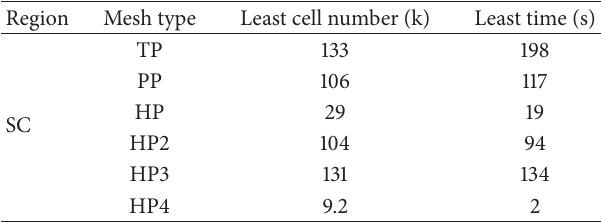
Table 2: Computational cost of each mesh type for